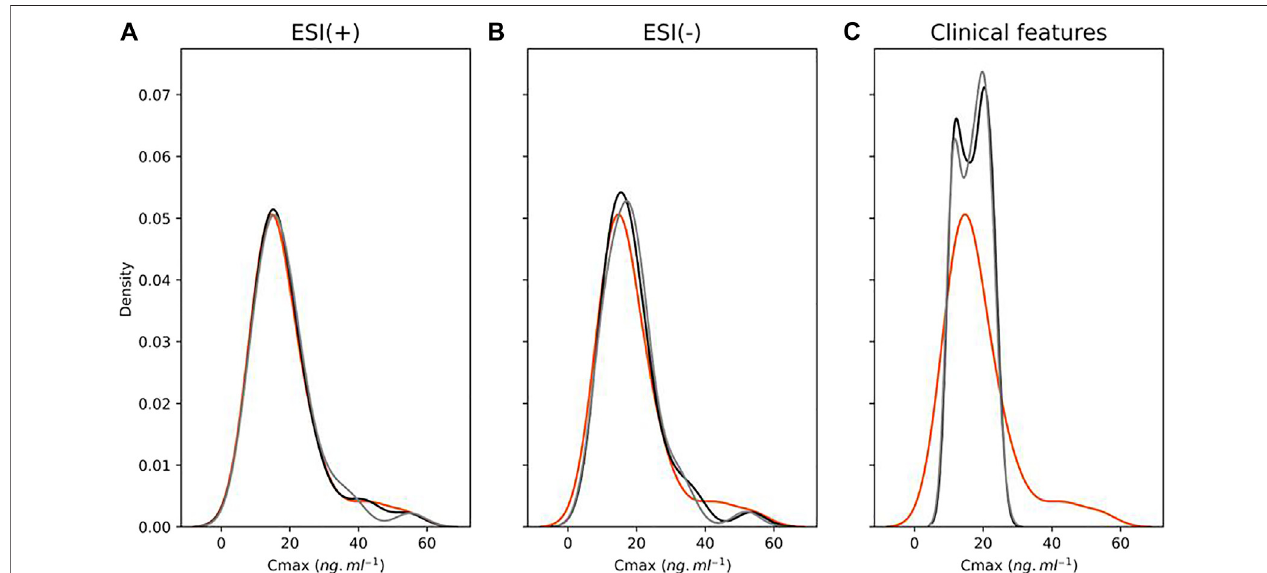
FIGURE 10 | Distribution plots showing the frequency of maximum plasma drug concentration ( C max ) values of true (orange), training set (black) predicted, and leave-one-out cross-validation (LOOCv) testing (gray) predicted from ESI (+) (A) , ESI ( − ) (B) , and clinical features (C)